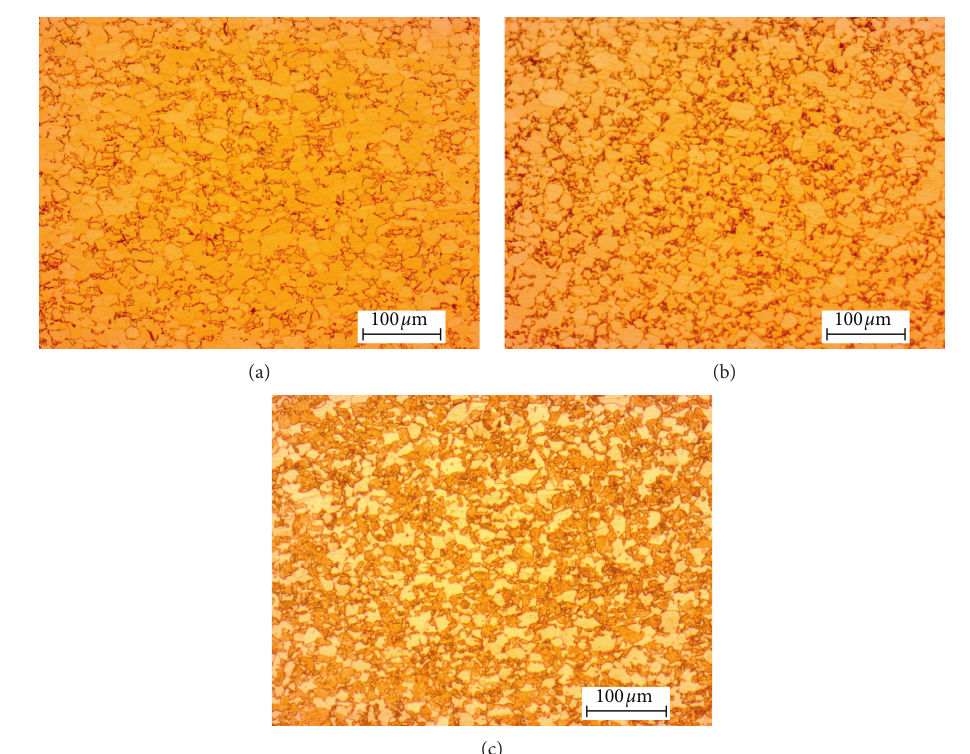
Figure 6: Microstructures of the steel at different temperatures with thickness reduction of 60%: (a) 740 ° C; (b)785 ° C; (c) 830 °